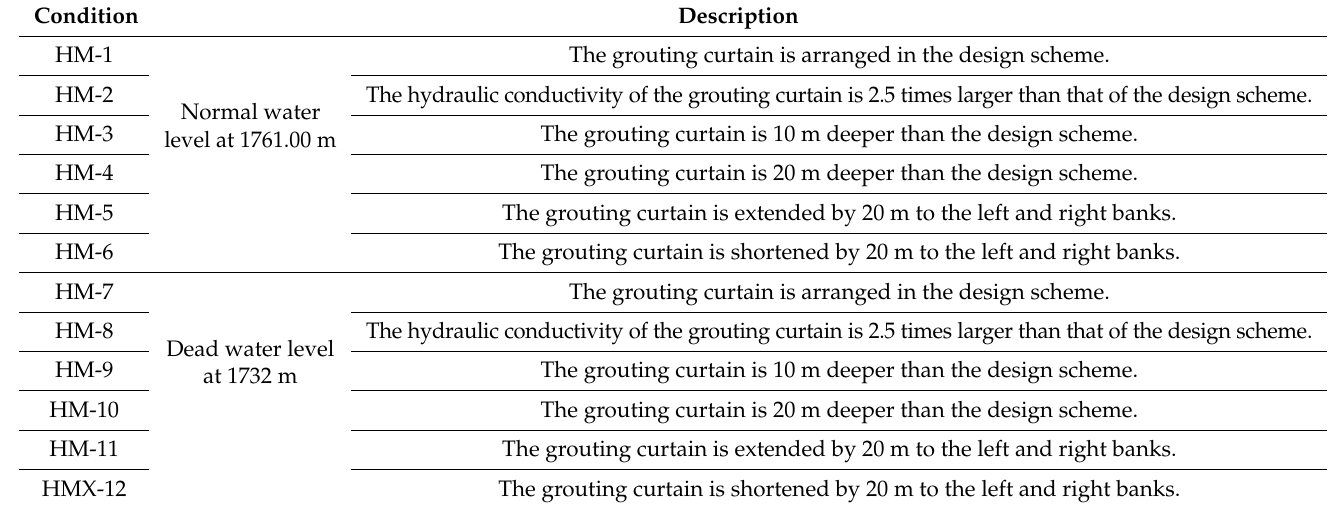
Table 3. Optimization calculation working conditions of the grouting curtain layout.